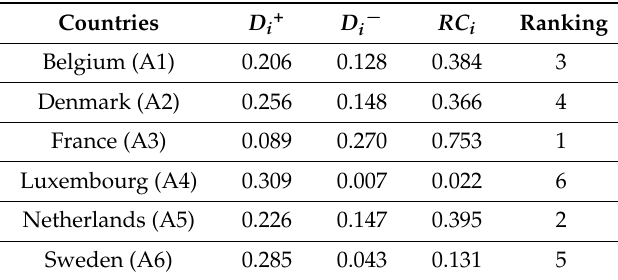
Table 15. Ranking results of the international transport export including energy trade for the selected EU countries in